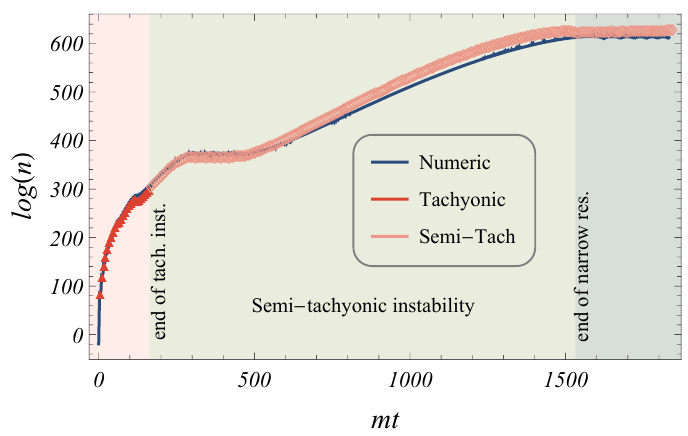
Figure 5 . Logarithm of the number density of photons for a larger period of time until the end of particle production (ignoring backreaction effects). The photon wave-number is set to k = mκ ∗ and the we have shown only the dominant polarization. For this plot we have set ϕ = 100 . The particle production history can be divided into three regimes. Initially, we have tachyonic instability until the time x et (see eq. (2.42) and below it). Then, we have semi-tachyonic regime until the time x en (see eq. (2.25)). After that we do not have efficient particle production. The blue curve is obtained from numeric solution while red and pink point are obtained by the analytic results of eqs. (2.35) and (2.43) for the tachyonic and semi-tachyonic